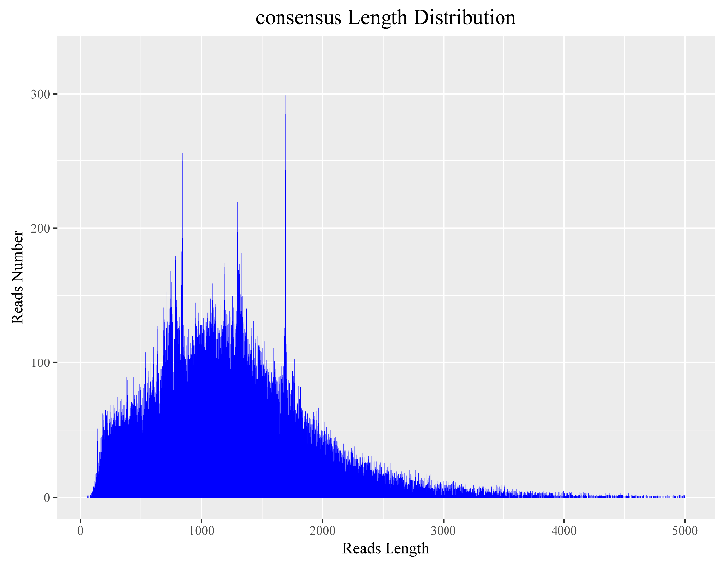
Figure 2. Consensus length distribution . The abscissa is the length of consensus, and the ordinate is the number of the consensus length.